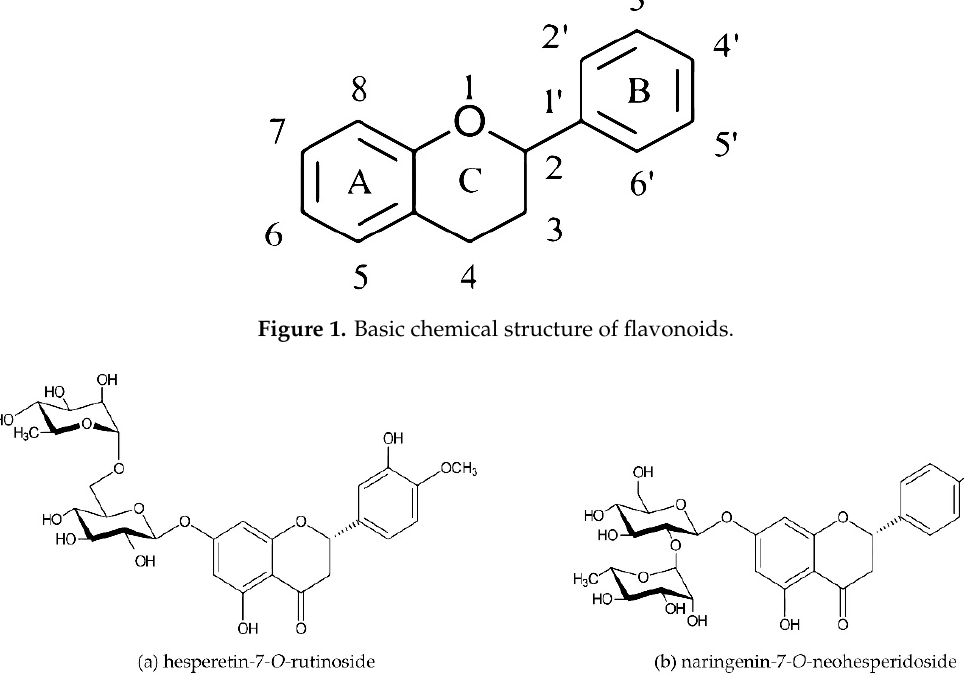
Figure 2. Chemical structure of hesperidin ( a ) and naringin ( b ).